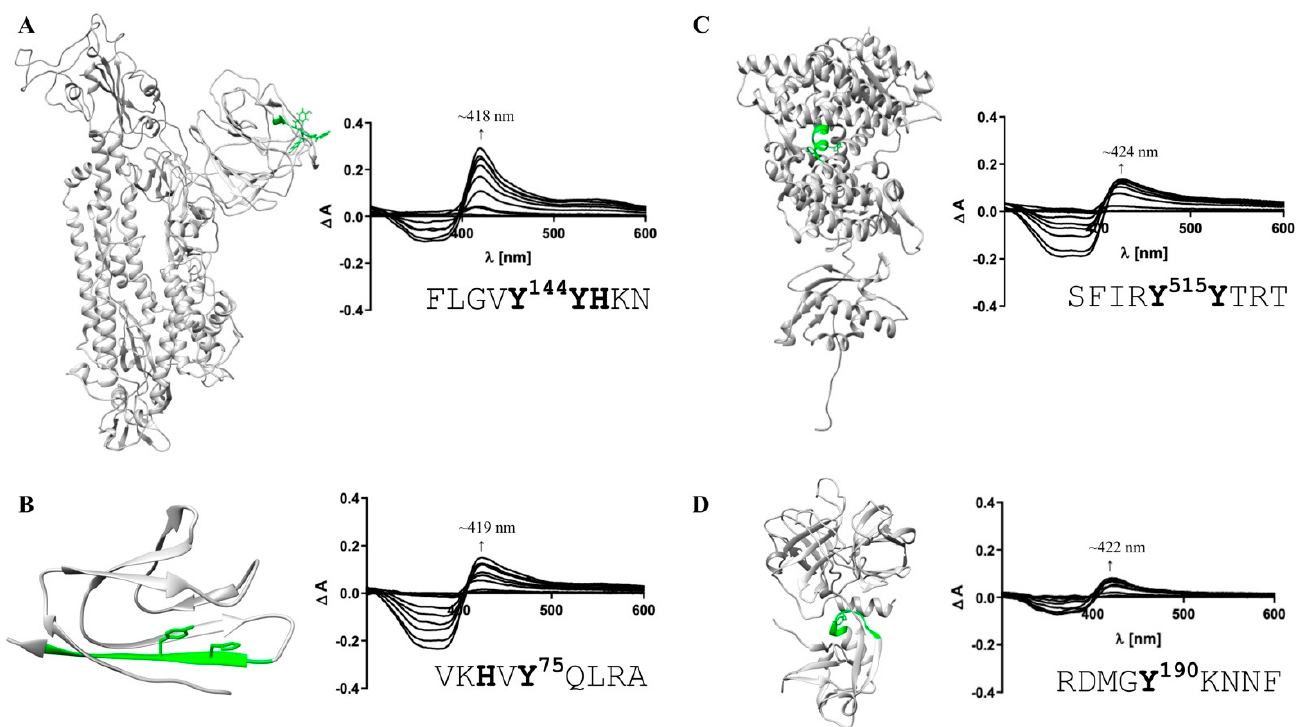
Figure 4. Heme-binding capacity of the most promising HBMs in SARS-CoV-2 and host cell proteins. Heme (0.4–40 µ M)- binding properties of the motif-derived peptides (10 µ M) were investigated by UV-Vis spectroscopy. The locations of the most promising HBMs within the proteins’ structures (extracellular part; left) and the difference spectra (right) are depicted. ( A ) With a K D of 0.96 ± 0.47 µ M (right), FLGV Y 144 YH KN (green) was the HBM with the highest heme-binding affinity in the S protein. ( B ) For protein 7a (PDB: 6W37), VK H V Y 75 QLRA was confirmed as a HBM (K D determination not possible). ( C ) Within human ACE2, the motif SFIR Y 515 Y TRT (green) exhibited the highest heme-binding affinity (K D = 0.60 ± 0.33 µ M). ( D ) For TMPRSS2, one HBM with high heme-binding affinity in the SRCR domain was identified (RDMGY 190 KNNF; K D = 0.94 ± 0.38 µ M). HBMs that emerged only as moderate heme binders are not shown (Figure